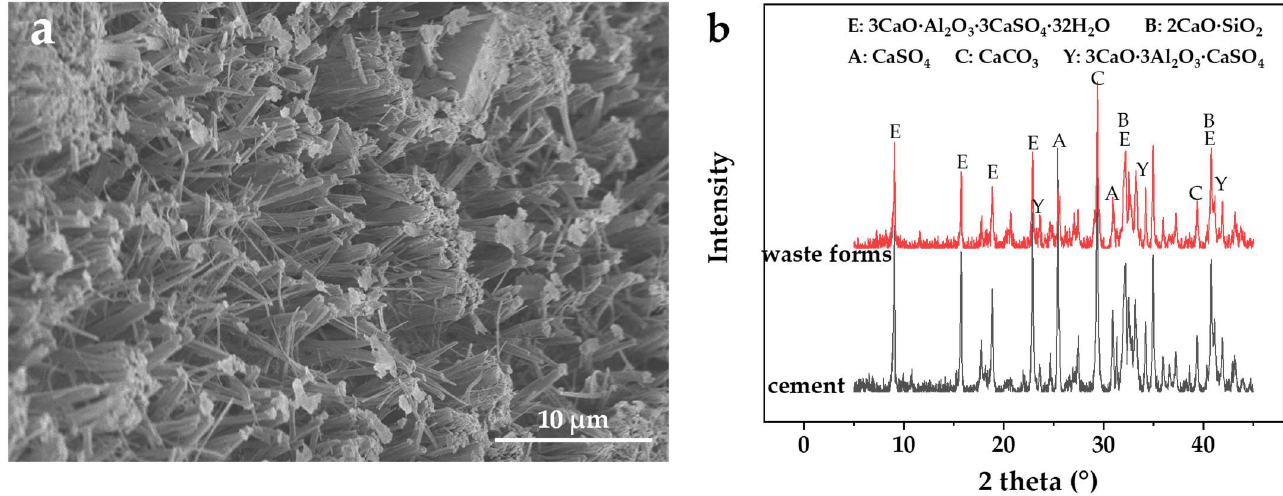
Figure 4. Characterization of metakaolin-reinforced wasteforms: ( a ) SEM image and ( b ) XRD spectra (red), with the mixture composition of spent resin 40 wt.%, sulfoaluminate cement 55.8 wt.%, metakaolin 2.2 wt.%, and naphthalenesulfonate water reducer 2 wt.%; the hardened cement XRD spectra (black) as comparison, with the mixture composition of water 40 wt.%, sulfoaluminate cement 55.8 wt.%, metakaolin 2.2 wt.%, and naphthalenesulfonate water reducer 2 wt.%.